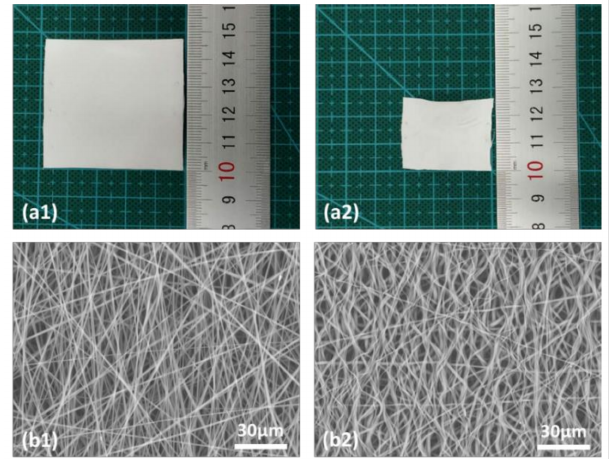
Figure 2. ( a ) Typical sample (applied voltage: 10 kV; solution concentration: 15%; distance between electrodes: 10 cm; speed of collector: 700 rpm/min; solution flow rate: 1.2 mL/h) before ( a1 ) and after ( a2 ) ethanol wetting. ( b ) SEM images before ( b1 ) and after ( b2 )